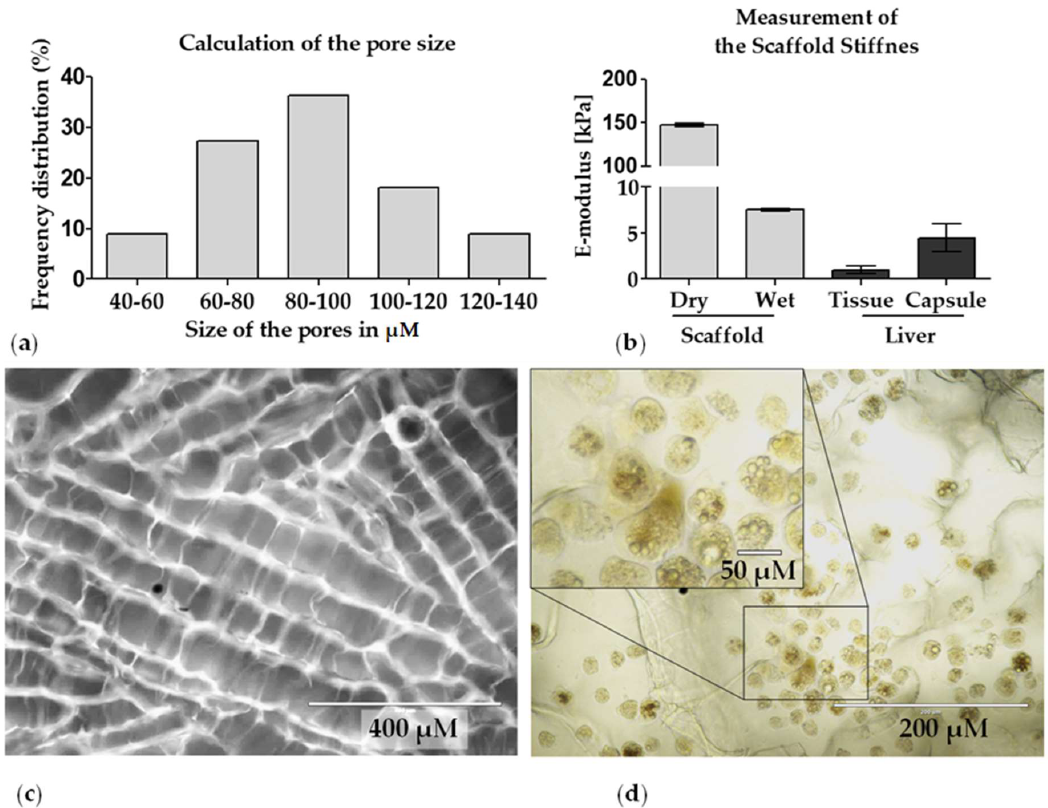
Figure 2. Physical characteristics of the Optimaix-3D scaffold: ( a ) pore size distribution was determined with the ImageJ software. (N = 4, n = 5). ( b ) The stiffness of the scaffold was measured with the help of a Zwick material testing machine (N = 4, n = 3). ( c ) Representative fluorescent microscopic picture of the pore structure in the Optimaix-3D scaffold. For visualization Optimaix-3D scaffolds were stained with SRB. ( d ) Microscopic image of the scaffold colonized with